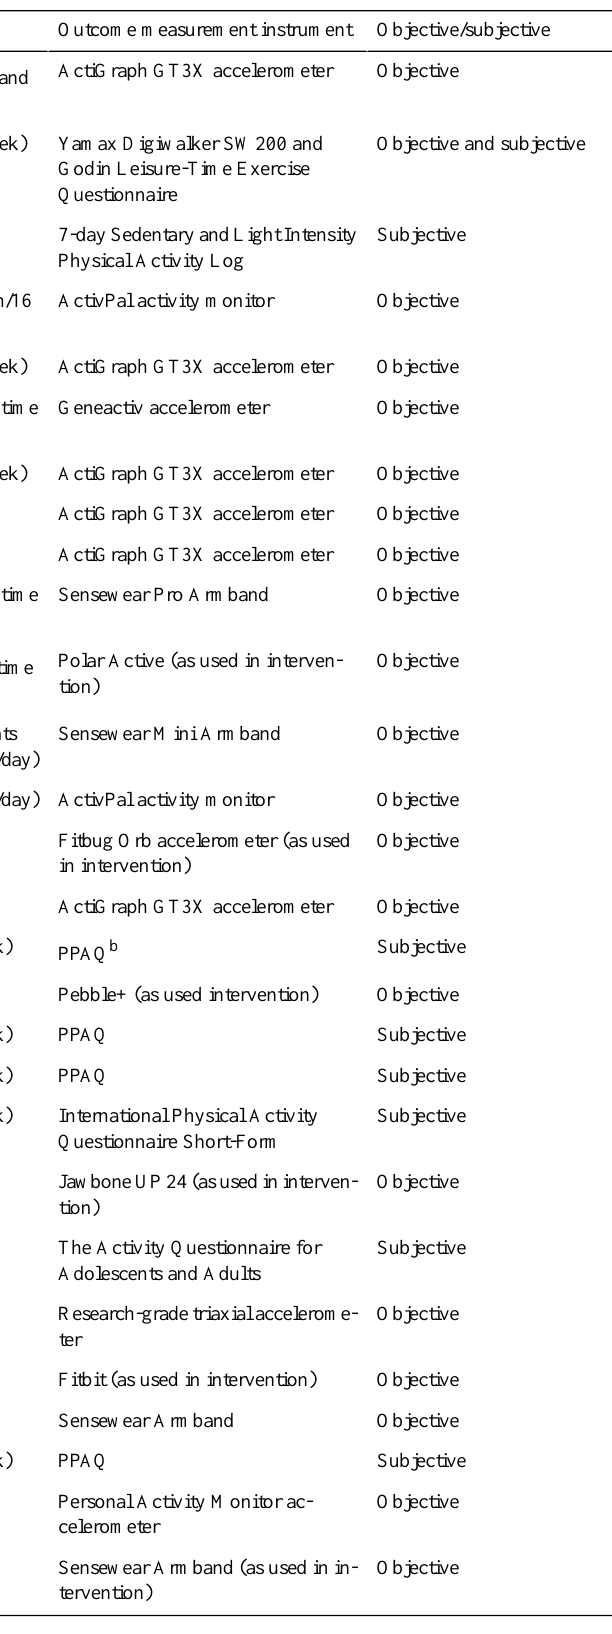
Table 1. Outcome measures of physical activity participation and sedentary